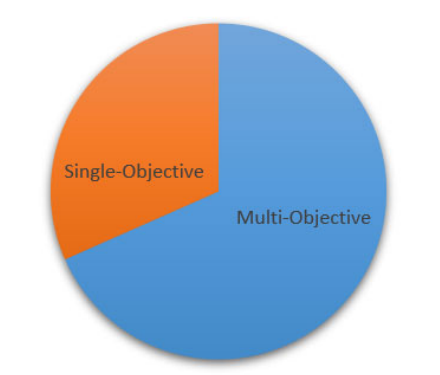
Fig. 2. Distribution of the types of objective functions Fig. 3. Distribution of the parameters in the TCTP